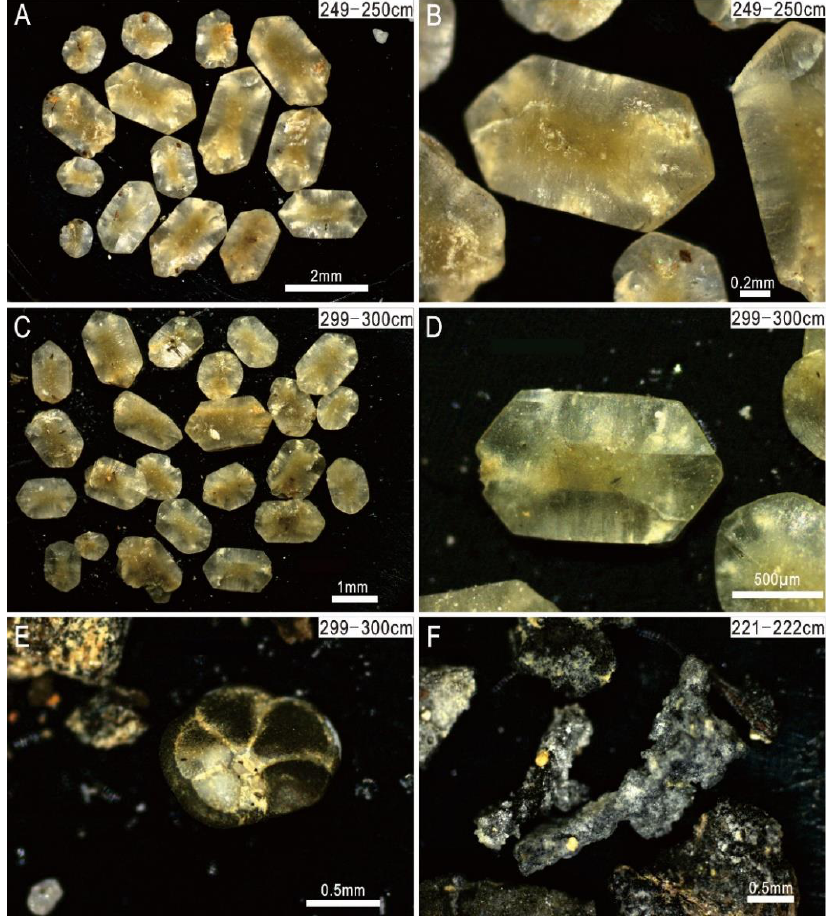
Figure 2. Microscopic observations of authigenic gypsum and pyrite. ( A ) Gypsum with prismatic, transparent and dull forms (249–250 cm depth); ( B ) prismatic gypsum crystals enclosing pyrite (249–250 cm depth); ( C ) prismatic, transparent and dull gypsum (299–300 cm); ( D ) prismatic gypsum crystals enclosing pyrite (299–300 cm); ( E ) A planktonic foraminifer coated with framboidal pyrite (299–300 cm); ( F ) tubular pyrite (221–222 cm).